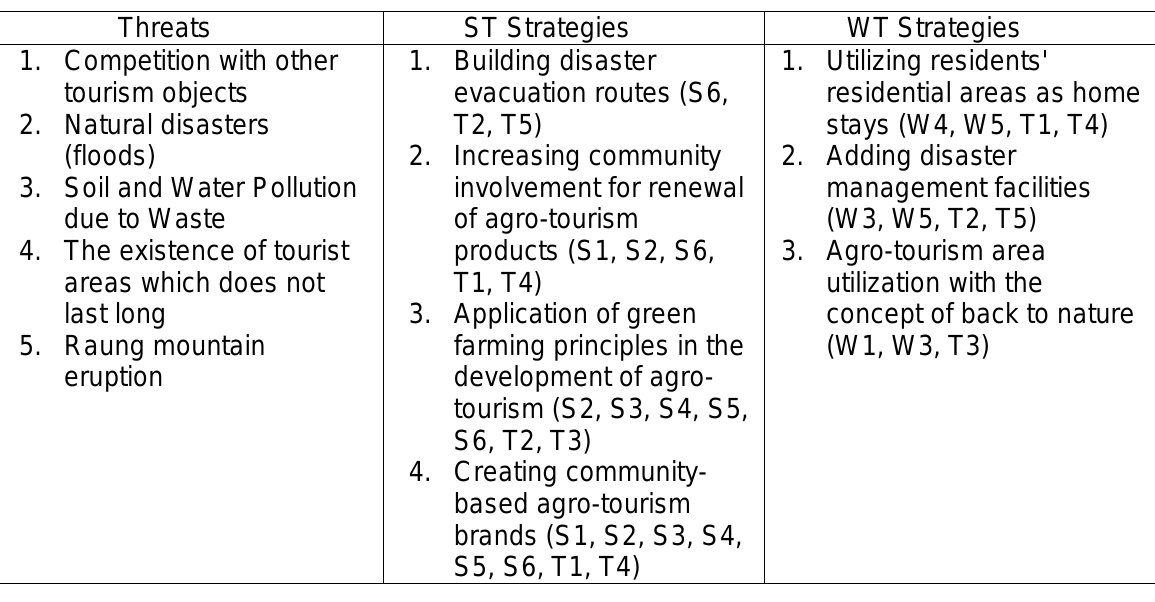
Results of Evaluation of Development